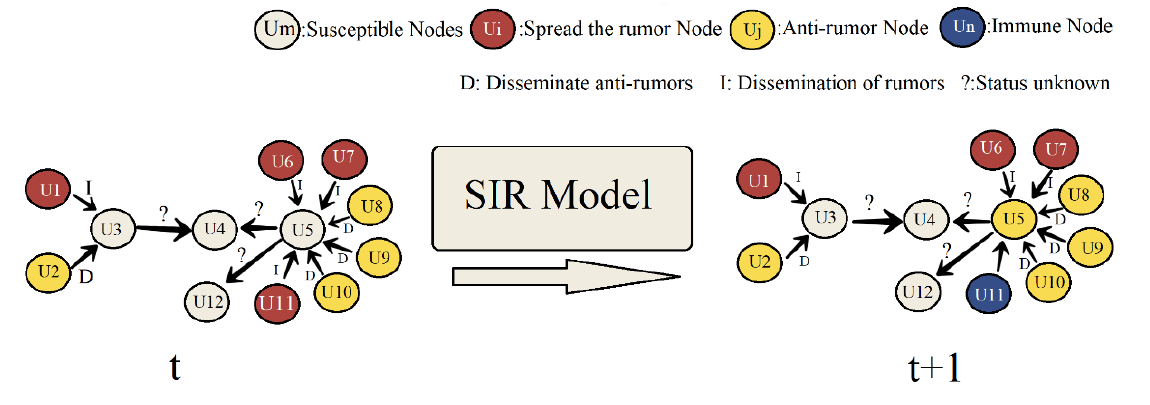
Figure 3. The dissemination process of SDIR model from t to t +